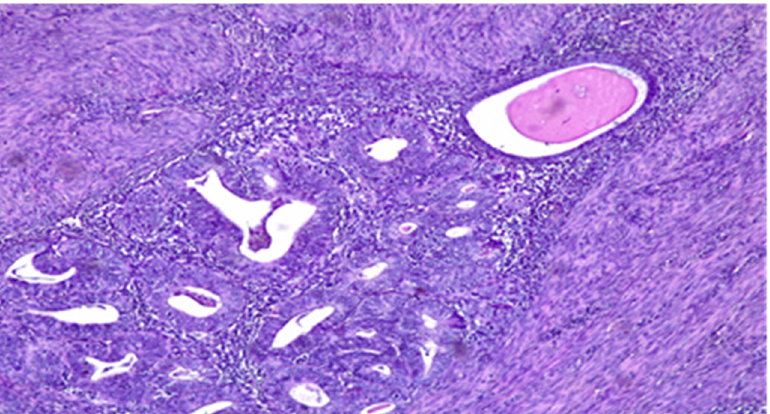
Figure 2. Adenomyosis involved by EEC—residual endometrial stroma and a single normal gland (top right) around the tumor nest. HE × 10.